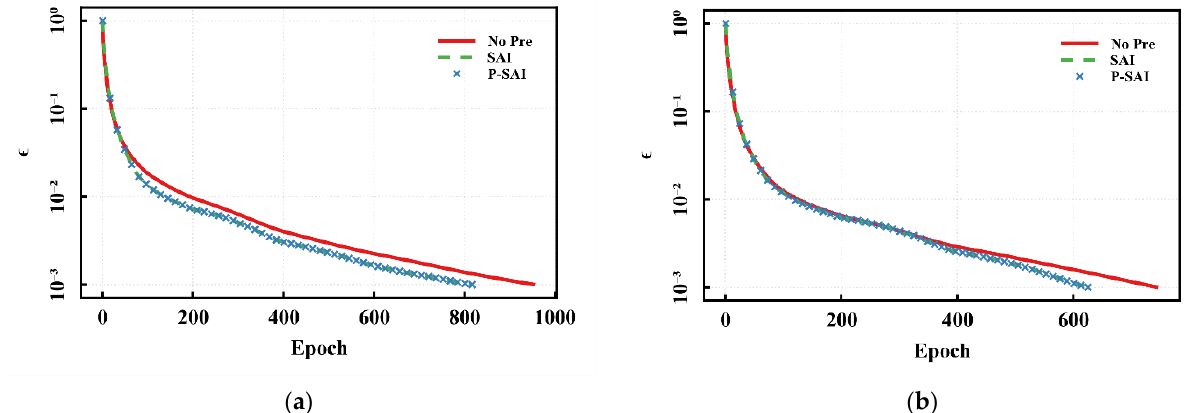
Figure 3. The relative residual errors in convergence history of GMRES are recorded by P−MoM with no preconditioner, SAI preconditioner and P−SAI preconditioner. The same examples in Figure 2 are used here: ( a ) Convergence history in solving the sum pattern; ( b ) convergence history in solving the difference pattern.